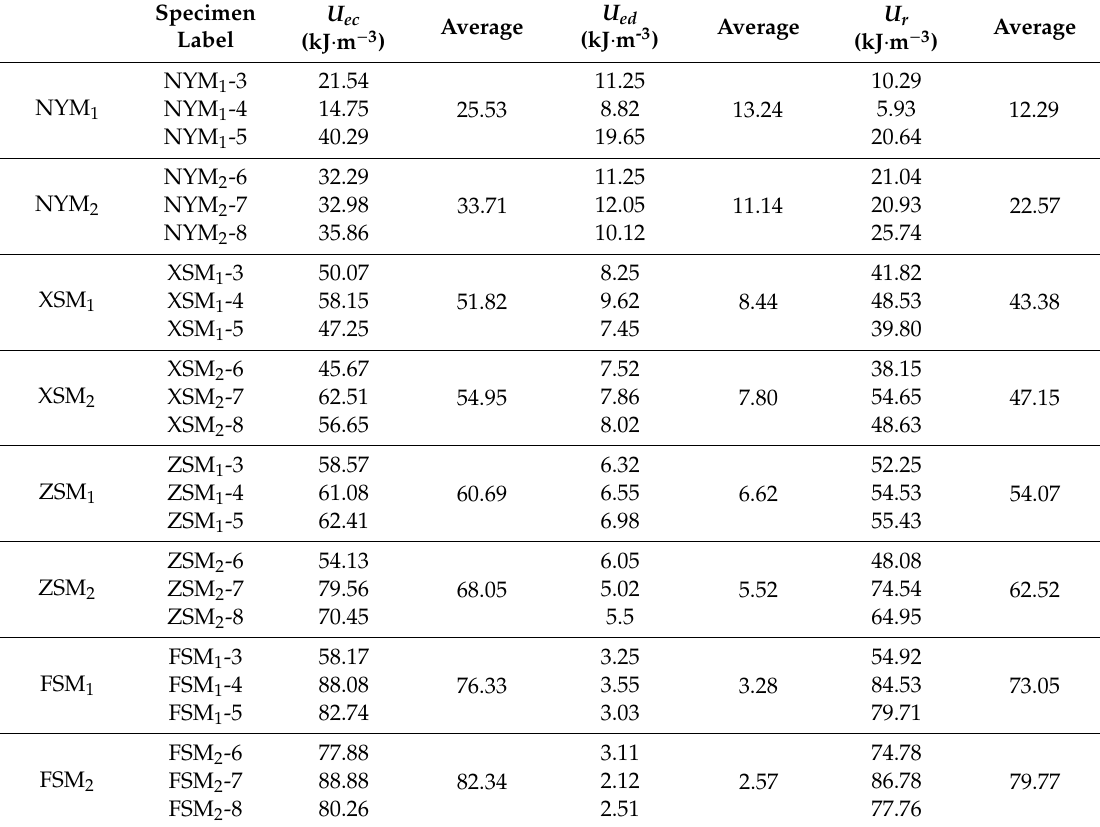
Table 4. The kinetic energy of the CRC